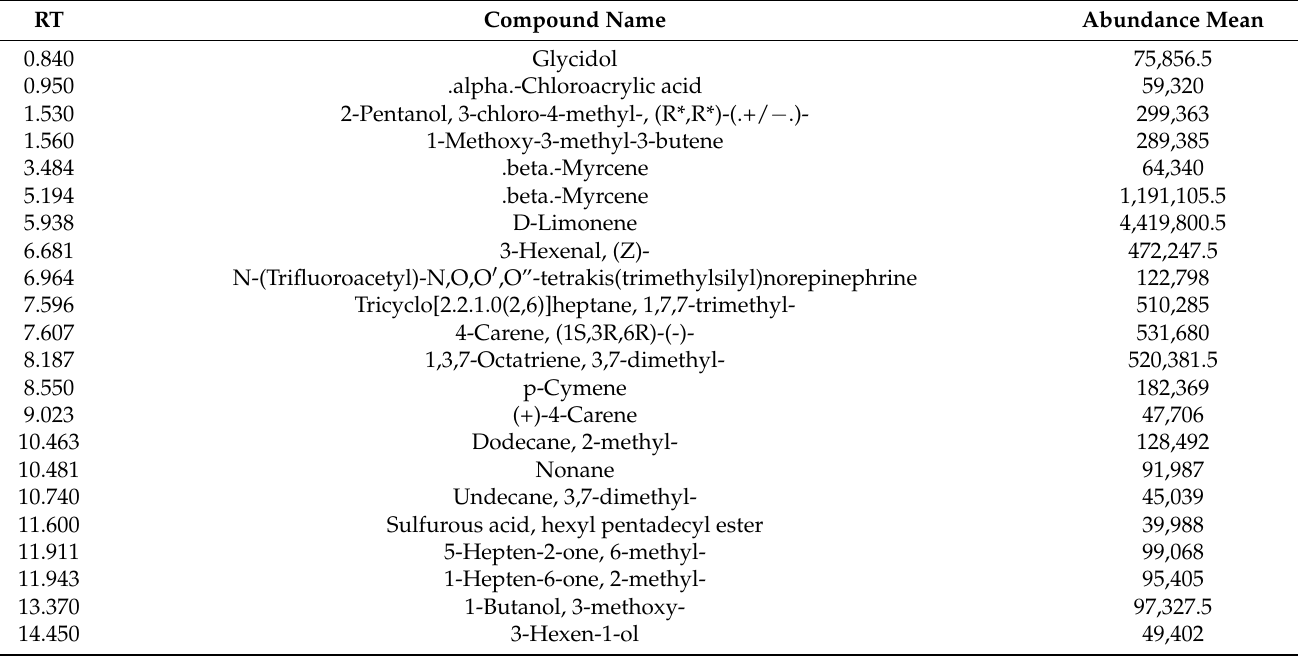
Table A8. Results for the EBB sample fingerprint determination with indication of the retention time (RT) and abundance mean for every identified